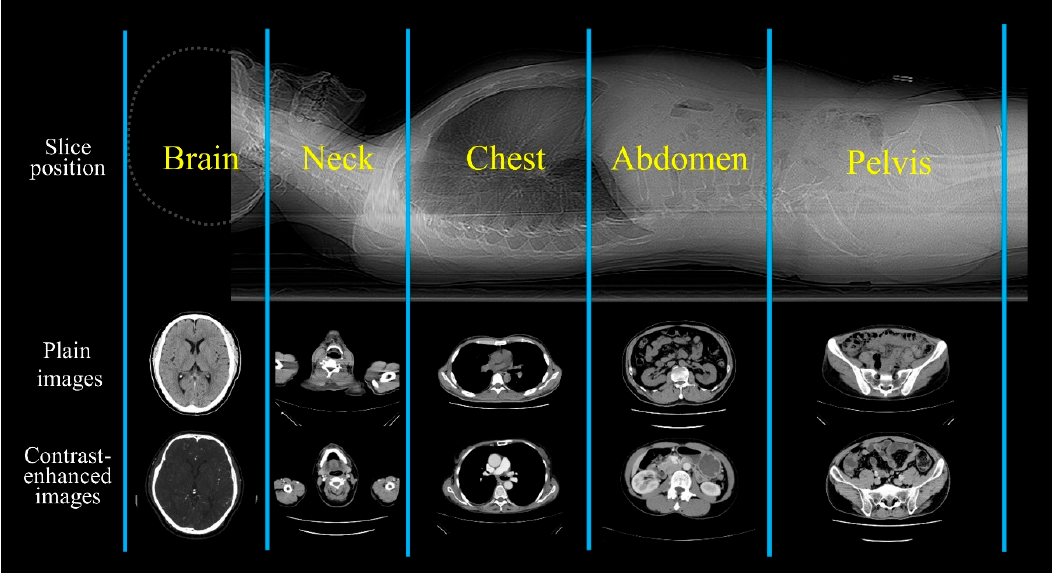
Figure 1. Slice position and sample CT images of the 10 classes.